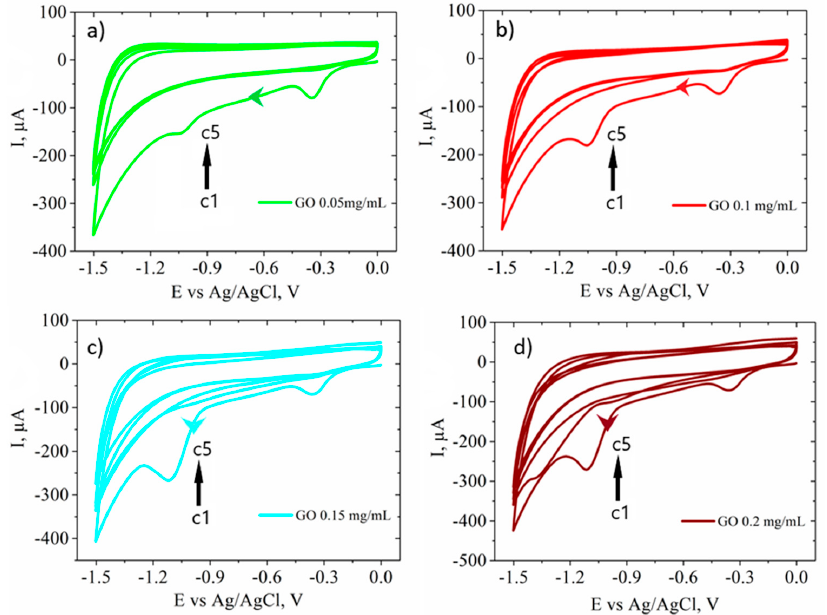
Figure 8. CVs (cycles (c) 1 to 5) showing the electrochemical reduction in 0.5 M KCl of GO-SPCEs obtained for different concentrations of GO dispersions: ( a ) 0.05 mg/mL; ( b ) 0.1 mg/mL; ( c ) 0.15 mg/mL; and ( d ) 0.2 mg/mL.